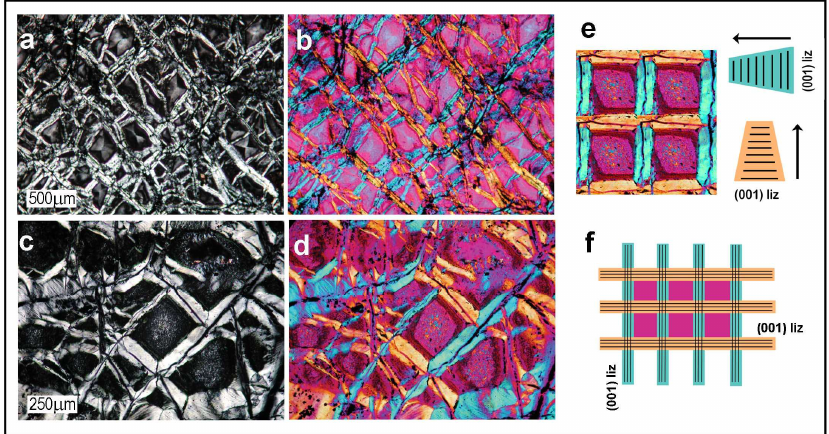
Figure 4. Microstructures of undeformed mesh textures: ( a , c ) Polarised-light images of undeformed mesh textures (crossed nicols). ( b , d ) Corresponding images with the retardation gypsum plate show pink-reddish cores formed by poorly crystalline random mixtures, and yellow/blue lizardite rims. ( e ) Four mesh cells (elaborated from ( d )) showing the two main orientations of (001) liz in rims (here, vertical in “blue” and horizontal in “yellow” rims). ( f ) 2D cartoon showing the occurrence of a sort of “crossed” CPO, with two main (001) liz orientations. In undeformed pseudomorphic serpentinites, the thickness of “blue” and “yellow” rims is similar